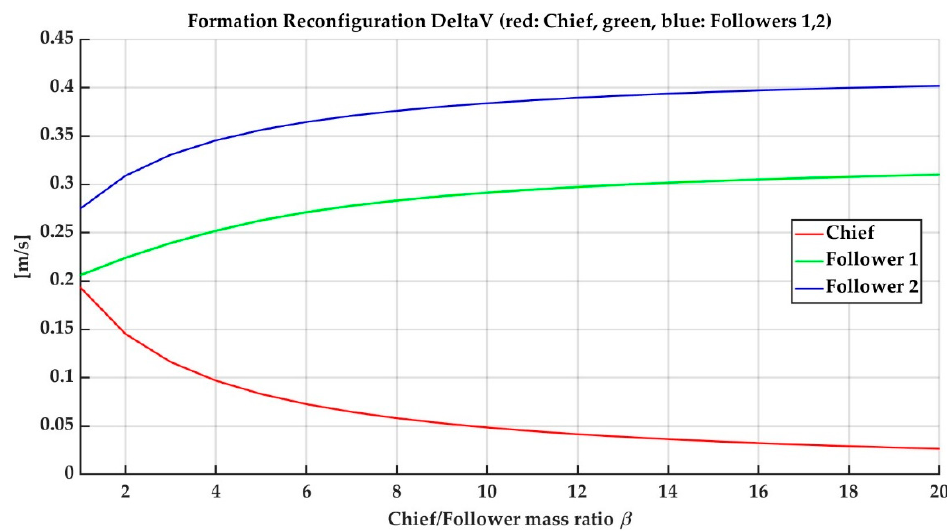
Figure 13. DeltaV on a formation reconfiguration as a function of the mass ratio 𝛽 .